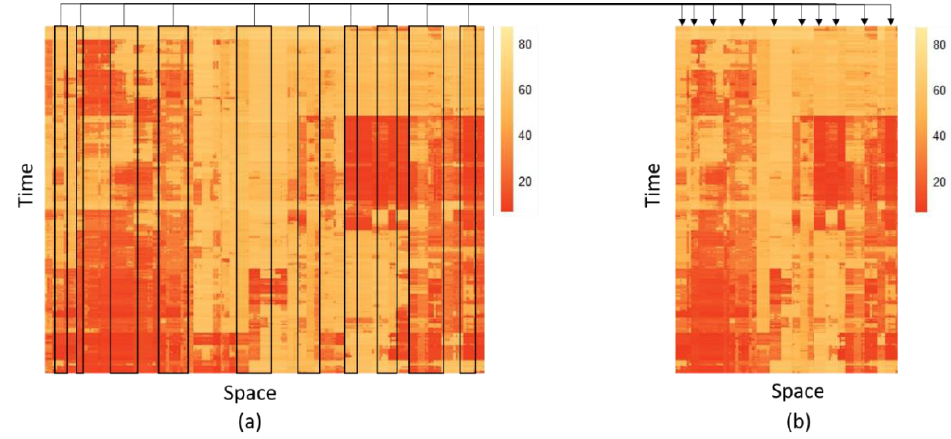
Figure 1. The process of shaping spatiotemporal matrix of critical road section: ( a ) A spatiotemporal matrix of overall network and ( b ) A spatiotemporal matrix of critical road sections.